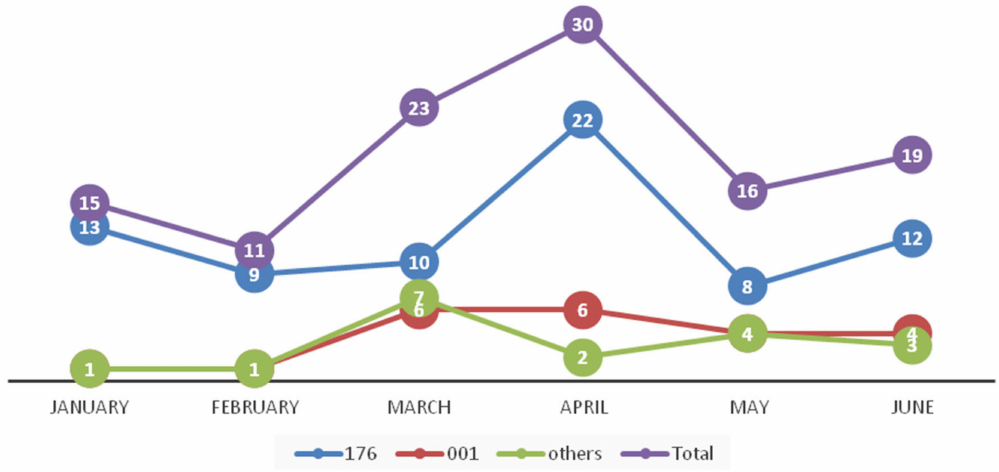
Figure 3. The distribution of ribotypes during the